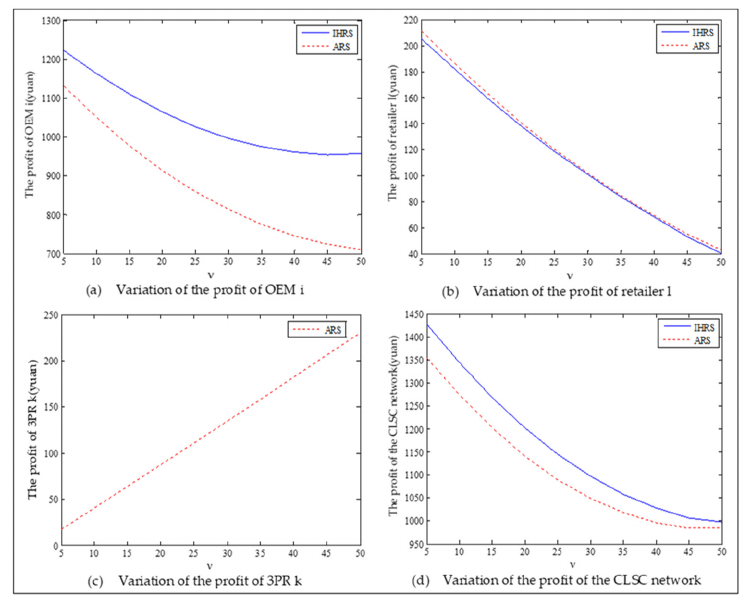
Figure 7. The variation of the profits in Case 1 of Section 6.1. Case 2: High lower limit of the recovery rate ( 1 α= ).